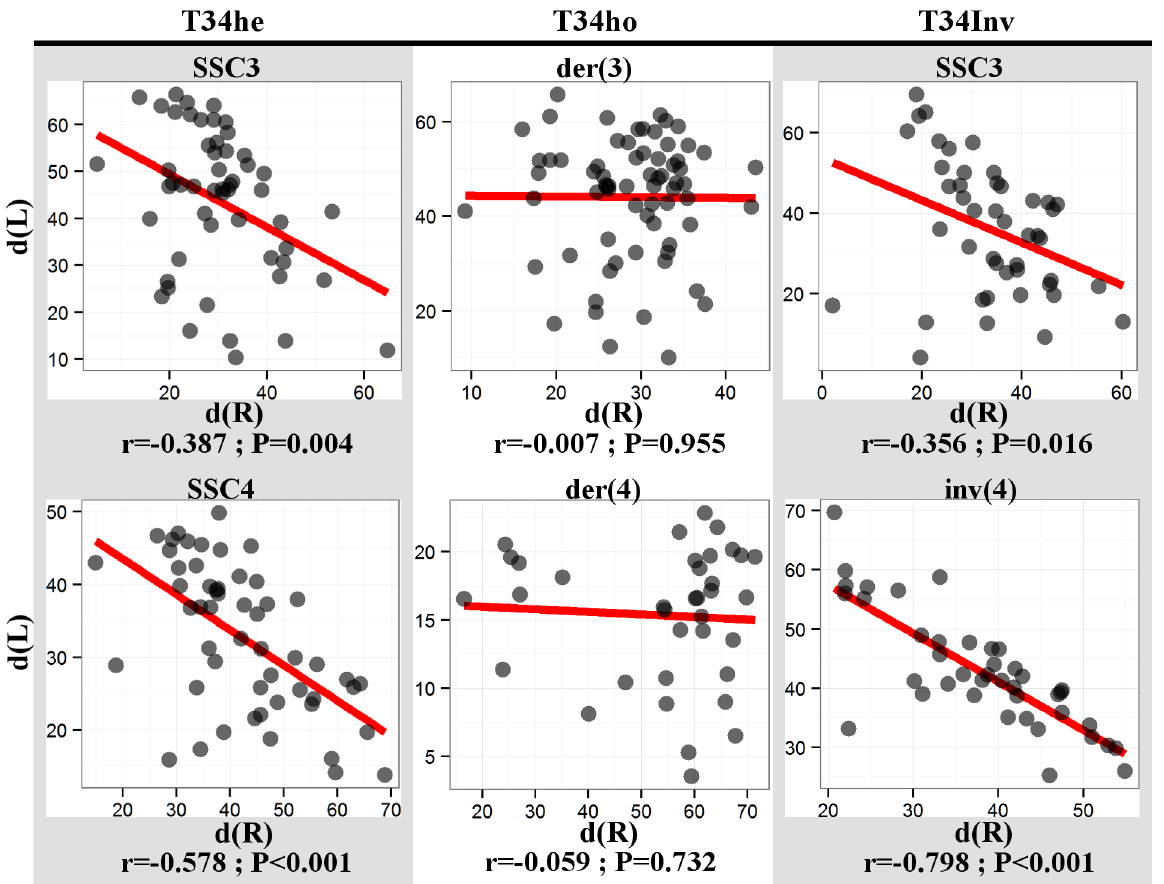
Fig 4. Relationship between the two distances from breakpoint to the nearest CO on the left [d(L)] and right [d(R)] sides of chromosomes that have at least one CO on each side. The results of the correlation analyses are indicated for each boar. The distances are expressed as percentage of the SC